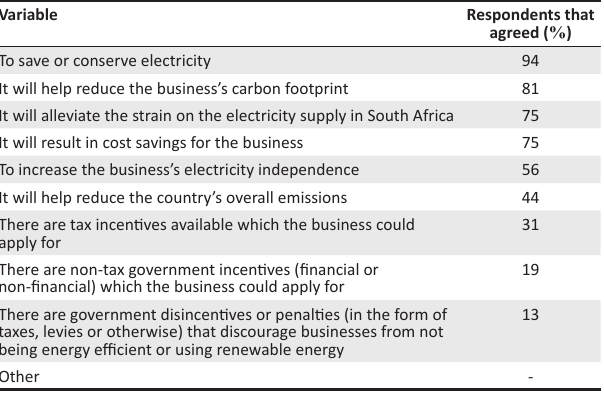
TABLE 4: Factors that play a role when deciding to implement energy efficiency or renewable energy measures. Variable